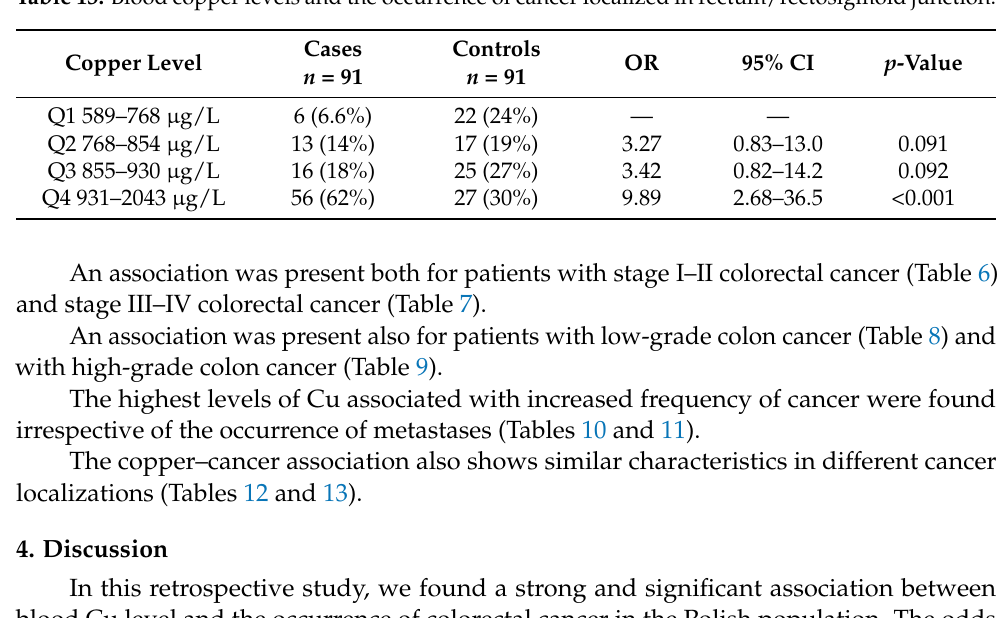
Table 13. Blood copper levels and the occurrence of cancer localized in rectum/rectosigmoid